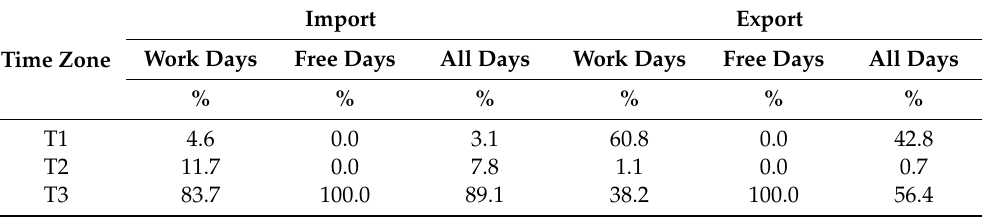
Table 5. Structure of imported and exported energy in the summer and heating seasons, and all year, for work days, free days and all days.